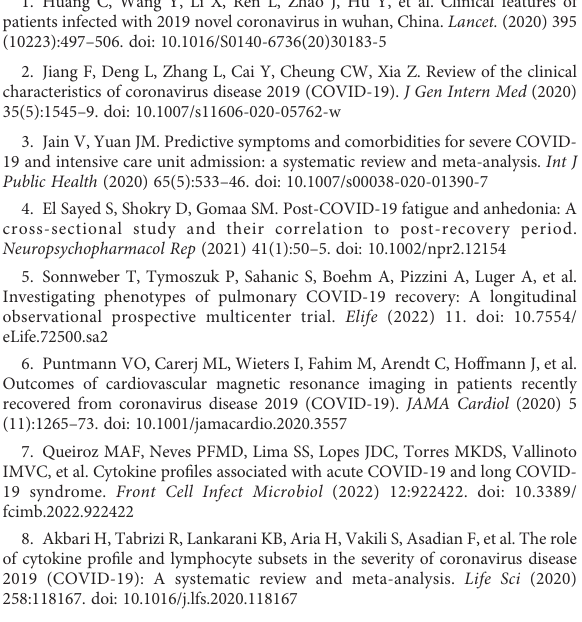
SUPPLEMENTARY FIGURE 1 Changes in chemokines from baseline to 12 weeks of Supervised and home-based unsupervised exercise on recovered COVID-19 patients. Comparison of variations between Supervised and home-based unsupervised exercise on the chemokines ’ serum levels according to T- test from baseline to 12 weeks of intervention (delta of Post- to Pre- intervention). Home,thehome-based unsupervisedexercisegroup;Gym, supervisedexercisegroup;Serumlevels; (A) IL-8:Interleukin-8( p =0.74); (B) CCL5: CC chemokine family-5 ( p = 0.06); (C) CXCL10: chemokine (C- X-C motif) ligand-10 ( p = 0.04); D) CXCL9: chemokine (C-X-C motif) ligand-9 ( p = 0.13); E) CCL2: CC chemokine family-2 ( p = 0.11); pg/mL: picogram per milliliter; *p< 0.05. SUPPLEMENTARY FIGURE 2 Changes in pro-in fl ammatory cytokines from baseline to 12 weeks of Supervised and home-based unsupervised exercise on recovered COVID-19 patients. Comparison of variations between Supervised and home-based unsupervised exercise on the pro-in fl ammatory cytokines ’ serumlevelsaccordingtoT-testfrombaselineto12weeksofintervention (delta of Post- toPre-intervention). Home, the home-based unsupervised exercise group; Gym, supervised exercise group; Serum levels; (A) IL-2: Interleukin-2 ( p = 0.04); (B) IL-6: Interleukin-6 ( p = 0.15); (C) TNF- a : Tumor necrosis factor-alpha ( p = 0.46; (D) IFN- g : Interferon-gamma ( p = 0.95); E) IL-17A: Interleukin-17A ( p = 0.01); pg/mL: picogram per milliliter; *p< 0.05. SUPPLEMENTARY FIGURE 3 Changes in anti-in fl ammatory cytokines from baseline to 12 weeks of Supervised and home-based unsupervised exercise on recovered COVID-19 patients. Comparison of variations between Supervised and home-based unsupervised exercise on the anti-in fl ammatory cytokines ’ serumlevelsaccordingtoT-testfrombaselineto12weeksofintervention (delta of Post- toPre-intervention). Home, the home-based unsupervised exercise group; Gym, supervised exercise group; Serum levels; (A) IL-4: Interleukin-4 ( p = 0.14); (B) IL-10: Interleukin-10 ( p = 0.88); (C) TNF- a /IL- 10 ratio: ( p = 0.60); pg/mL: picogram per milliliter; *p<